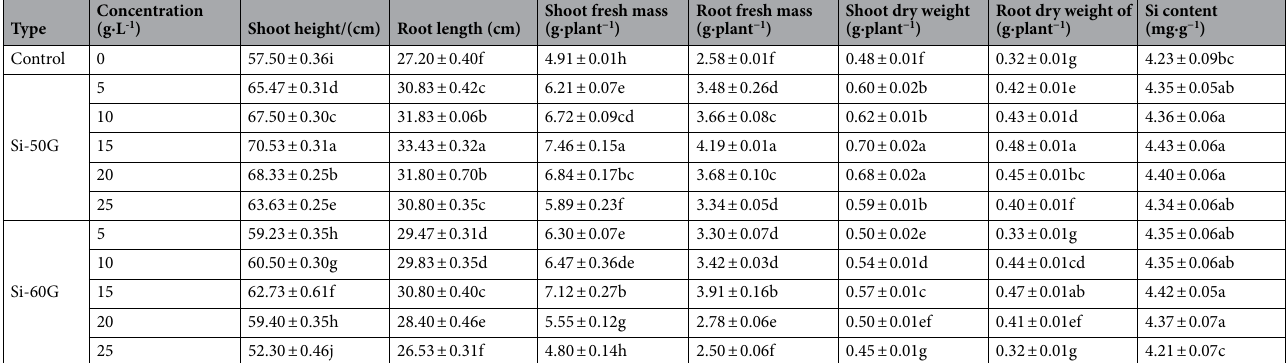
Table 2. Effects of Si (5, 10, 15, 20, and 25 g·L −1 ) on seedling growth. The values represent the mean ± SE (n = 4). Values with the same letters in the columns are not significantly different at P <